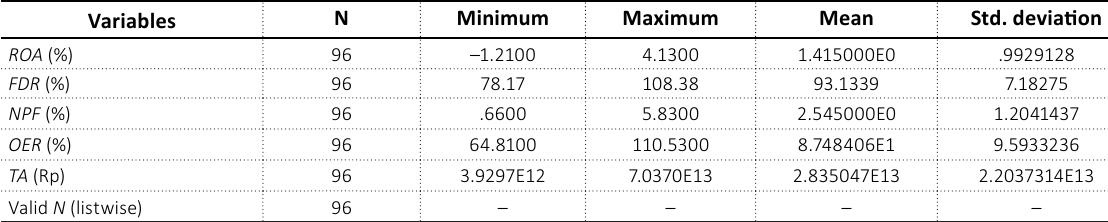
Table 4. Descriptive statistics of Indonesian Islamic